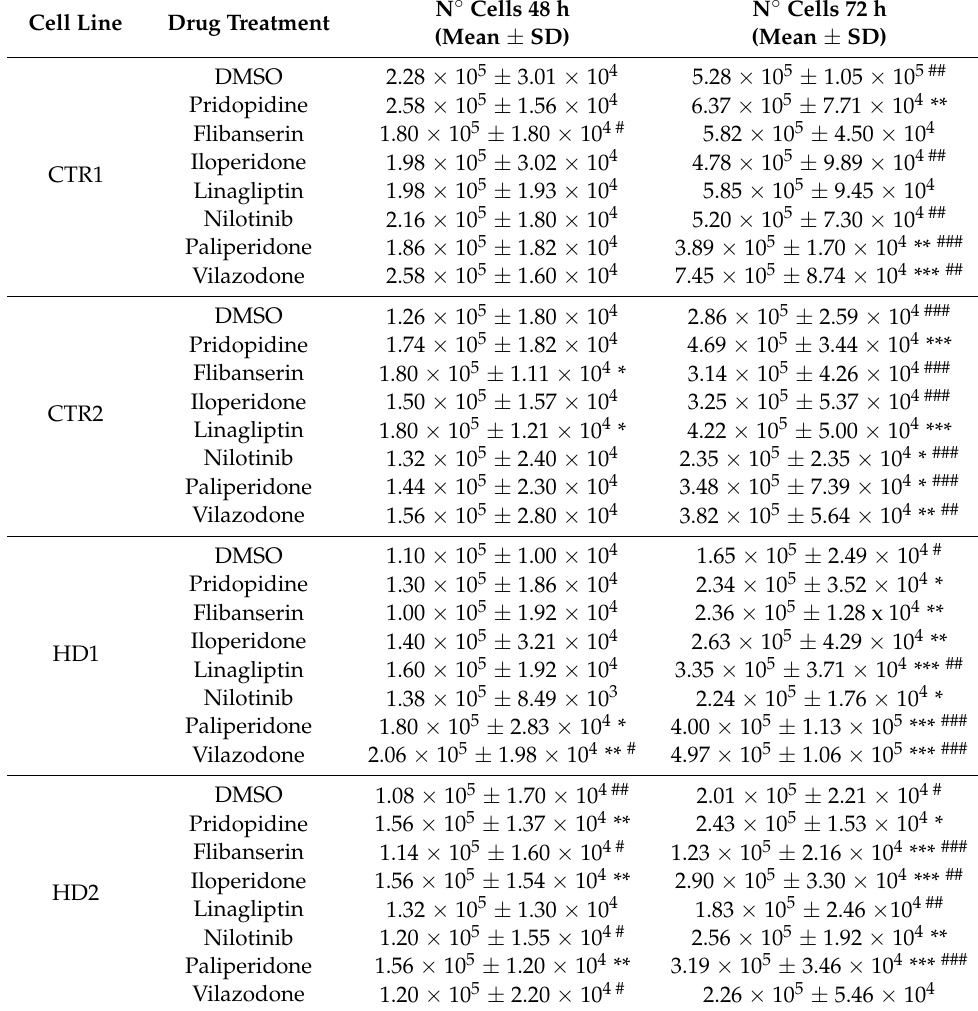
Table 7. Growth of CTR1, CTR2, HD1 and HD2 fibroblasts at 48 and 72 h after treatment with DMSO or 1 µ M pridopidine, iloperidone, linagliptin, flibanserin, paliperidone, vilazodone or nilotinib. The number of cells is reported as mean ± standard deviation (SD). * p < 0.05, ** p < 0.01, *** p < 0.0001, compared with DMSO treatment (Two-way ANOVA, followed by uncorrected Fisher’s LSD for multiple comparisons); # p < 0.05, ## p < 0.01, ### p < 0.0001, compared with pridopidine treatment (Two-way ANOVA, followed by uncorrected Fisher’s LSD for multiple